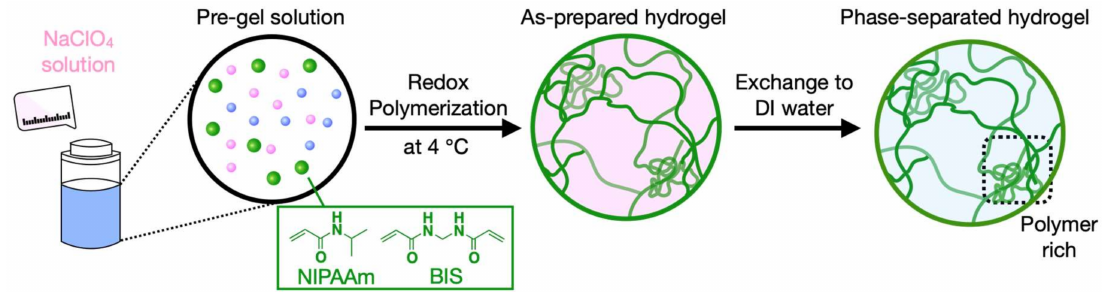
Figure 1. Schematic illustration of synthesis of phase-separated poly ( N -isopropylacrylamide) (PNIPAAm) hydrogel